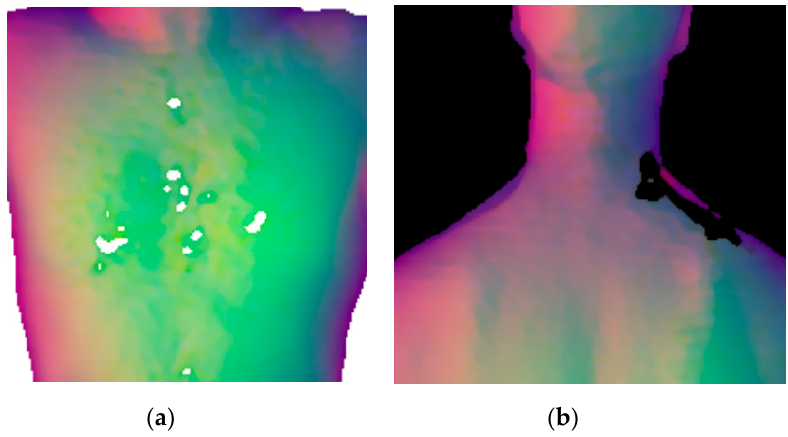
Figure 16. Examples of data with different types of defects: lesser ( a ) and significant ( b ).